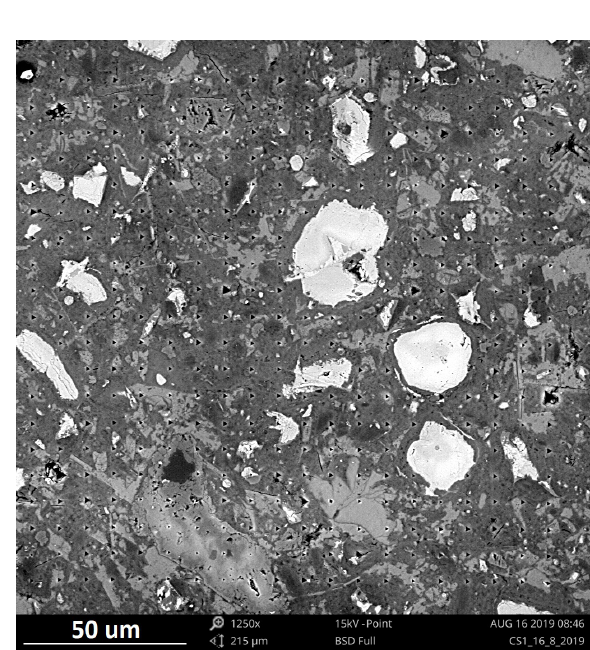
Figure 6. BSE images (phase